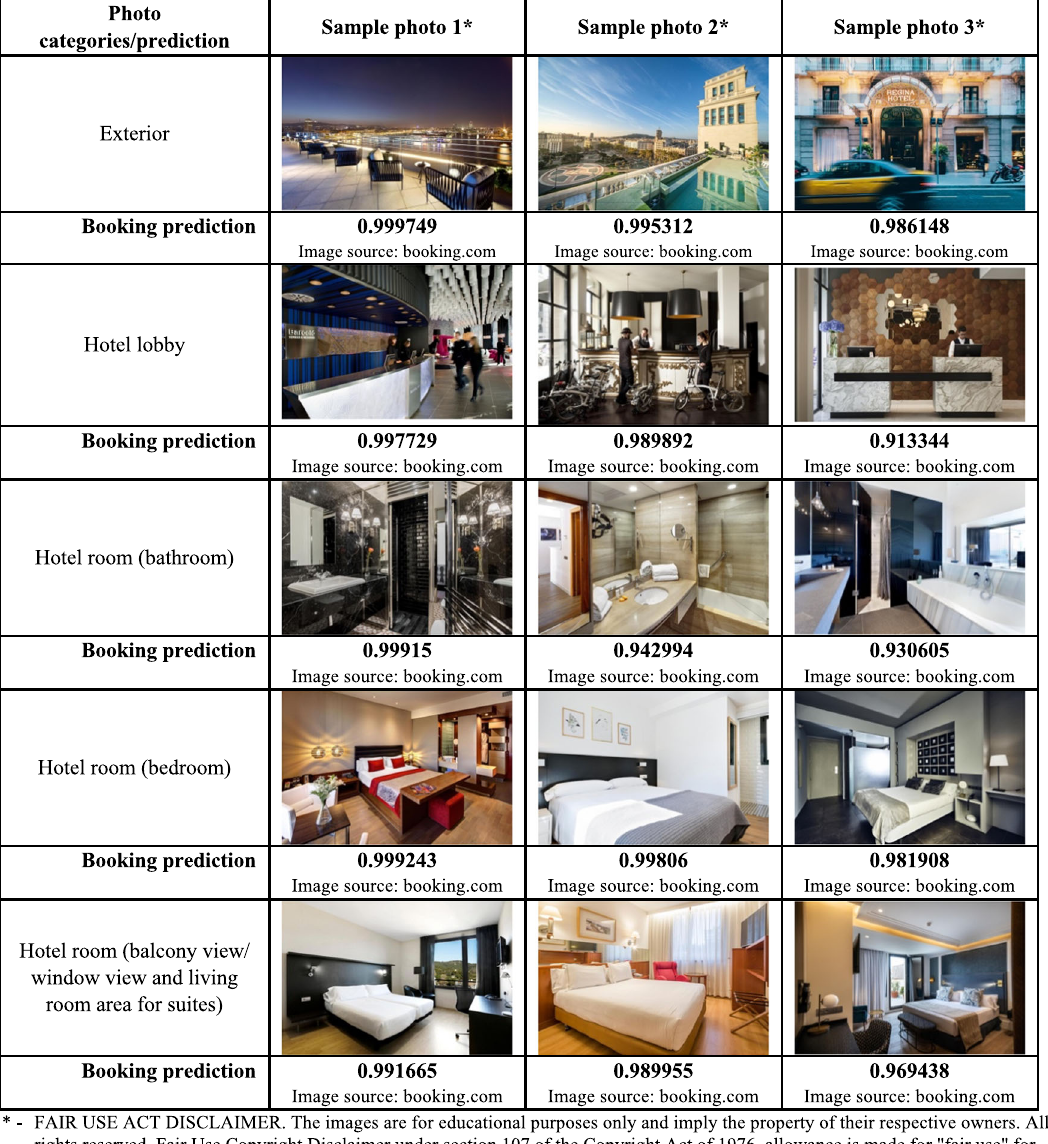
Fig. 4 The top-selling hotel photograph samples determined by logistic regression. The chart exhibits three sample photos for each of the fi ve composition categories (hotel exterior, lobby, and three room views) routinely utilised in hotel photography. The numbers under images indicate the prediction values of the hotel booking probability impelled by each photo according to the outputs of the logistic regression